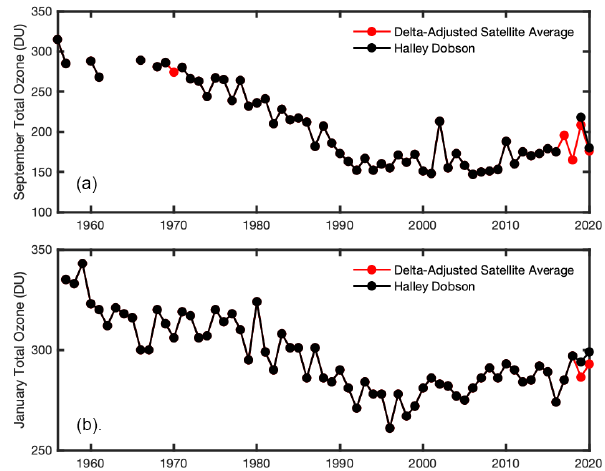
Figure 6. Monthly Halley ozone averages over time (black) for (a) September and (b) January, with the (cid:49) -adjusted satellite average (red) filled in for years with no or provisional Halley Dobson ob- servations. Note that GOME and SBUV data are not yet available. Dobson data from 2019 and 2020 were replaced due to apparent inconsistencies between the automated instrument and earlier